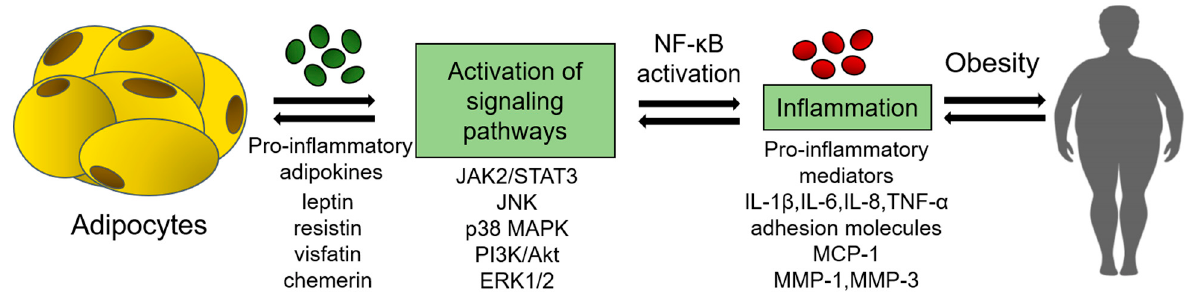
Figure 1. Pro-inflammatory effects of adipokines. ERK1/2—extracellular signal-regulated kinase